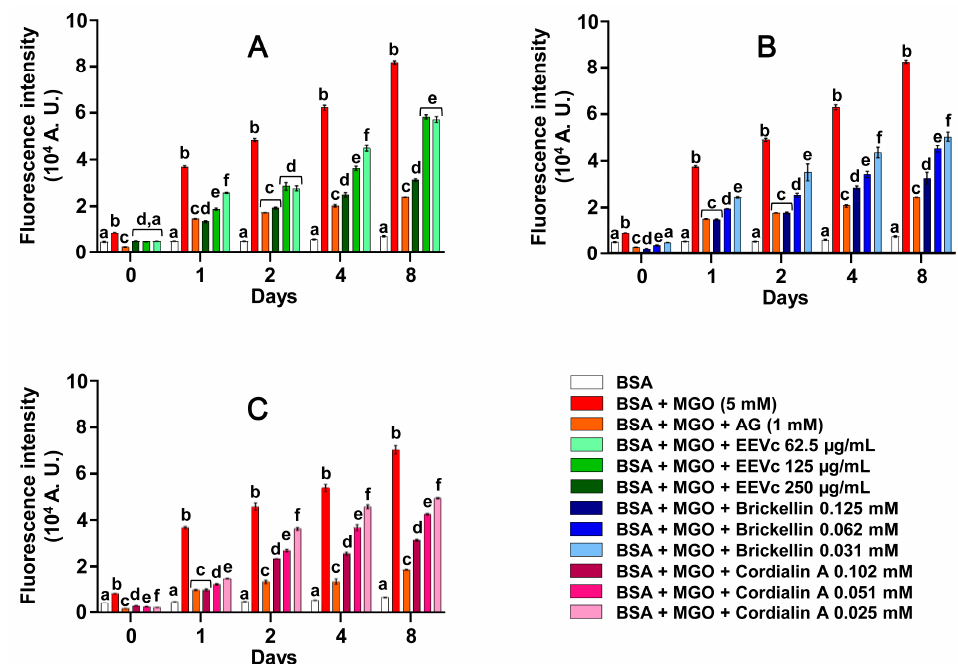
Figure 2. Effects of different concentrations of EEVc ( A ), brickellin ( B ) and cordialin A ( C ) on the formation of fluorescent AGEs in an in vitro model system of protein glycation with BSA + MGO. BSA: bovine serum albumin; MGO: methylglyoxal; AG: aminoguanidine; EEVc: ethanolic extract of V. curassavica . For all variables with the same letter, the difference between the means is not statistically